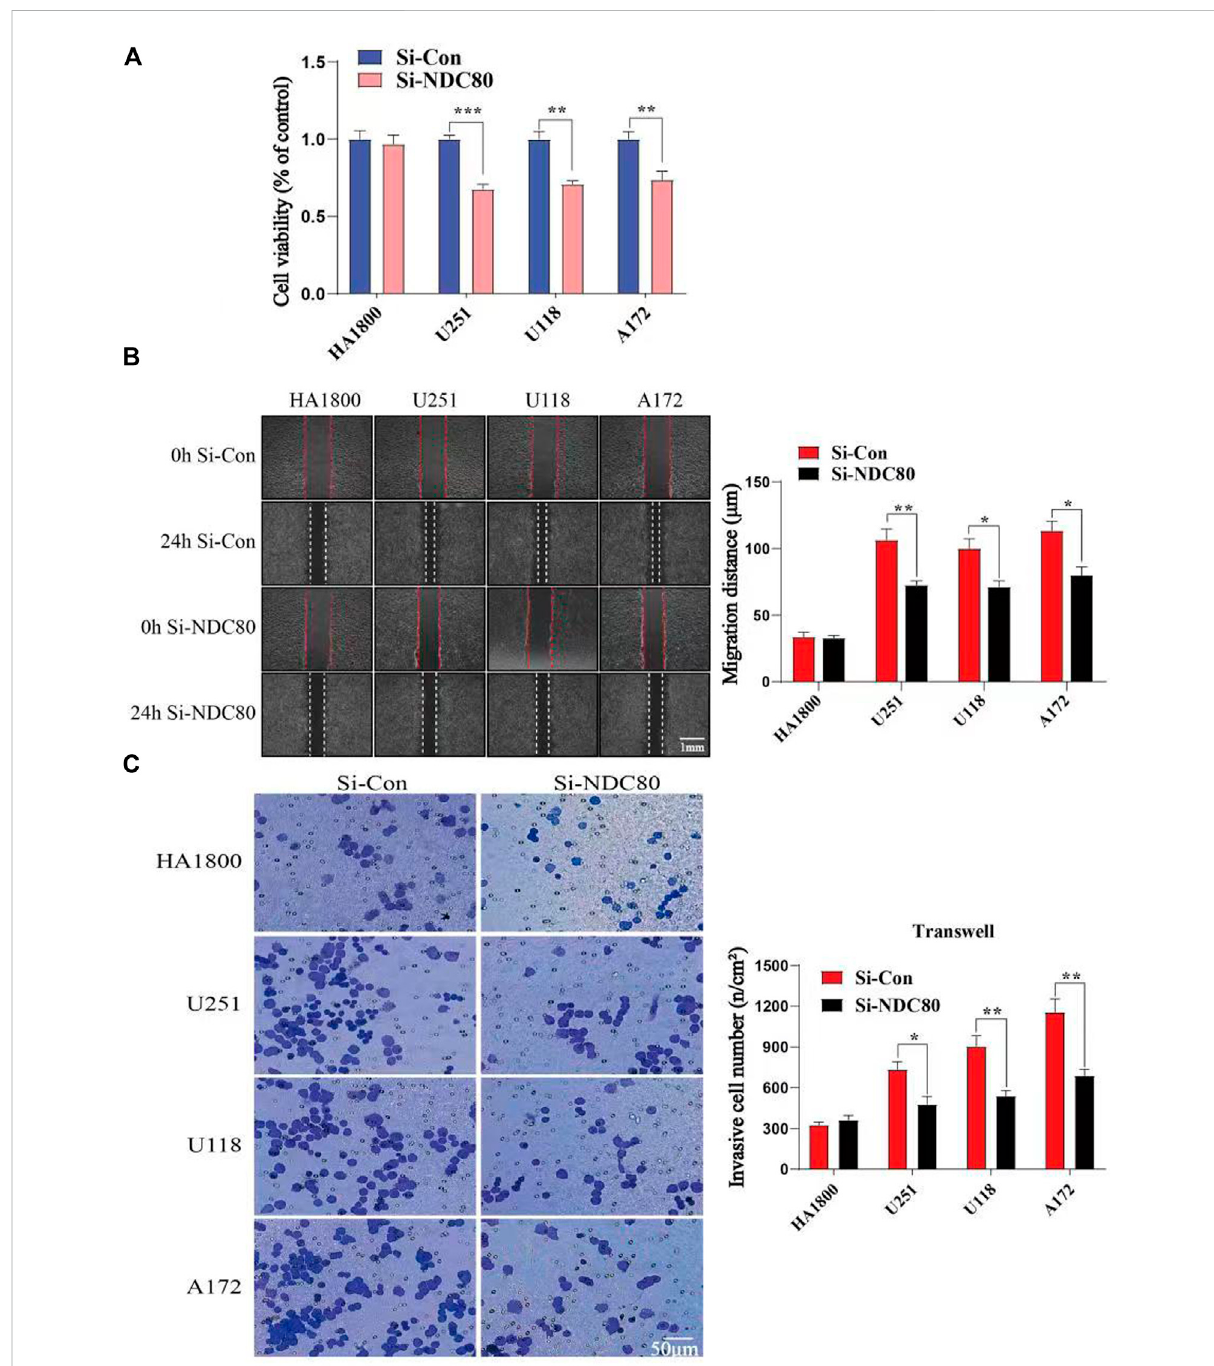
FIGURE 10 Compare the cell viability (OD value) and invasion ability of human glioblastoma cells with normal astrocytes in each group. (A) CCK-8 test suggests that Si-NDC can downregulate the cell viability of human glioblastoma cells; n = 5 samples per group; unpaired t -test. (B) Scratch assay showed that the migration ability of human glioblastoma cells (U251, U118, and A172) in the Si-NDC80 group was signi fi cantly lower than that of normalastrocytes; n =4testspergroup;unpaired t -test. (C) NumberofinvasivecellsintheSi-NDC80groupoftranswellinvadingexperimental human glioblastoma cells (U251, U118, and A172) was signi fi cantly lower than that of the control; n = 5 tests per group; unpaired t -test. Data are presented as mean ± SEM. * p < 0.05, ** p < 0.01, and *** p <